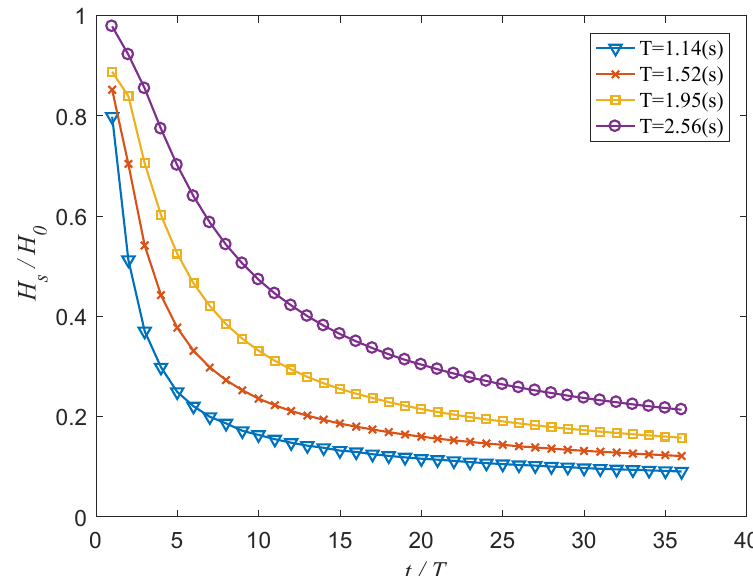
Figure 9. Variation of wave height versus time (period) of the leading wave.